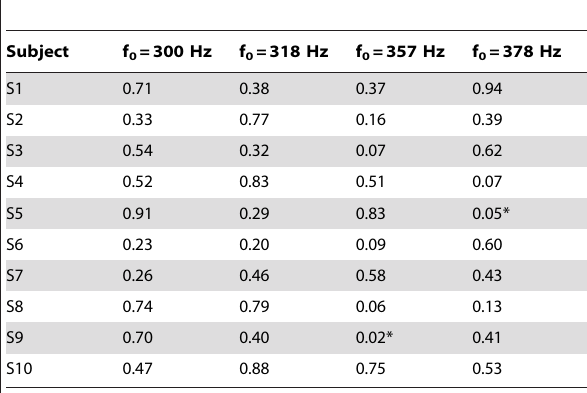
Note: The table shows uncorrected p-values for the slopes of the individual regressions of the standard deviation of the matched tones on timbre levels for each fundamental frequency f 0 . Uncorrected p-values are shown in this instance because these are the more conservative alternative when making the argument of no consistent directional effects. p-values . 0.05 mean that the hypothesis of equal slopes cannot be rejected. S1–10 indicates subjects from 1 to 10. *uncorrected p-value ,